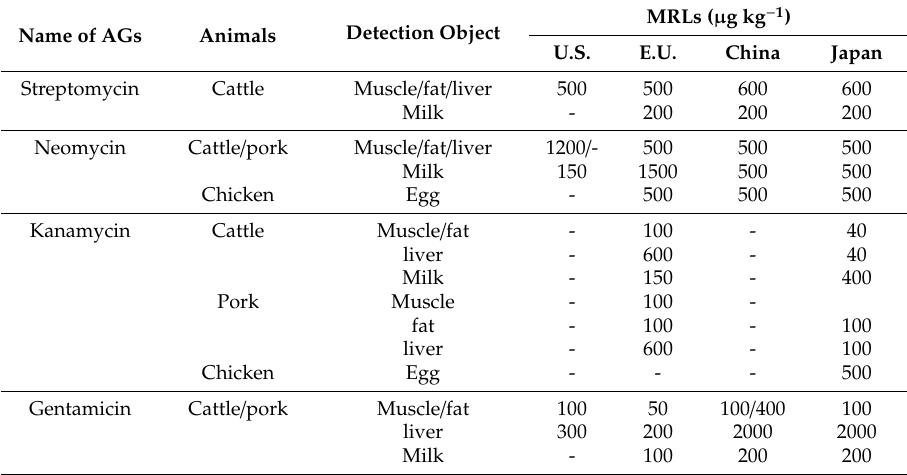
Table 1. Maximum residue limits (MRLs) of some AGs in different foods.